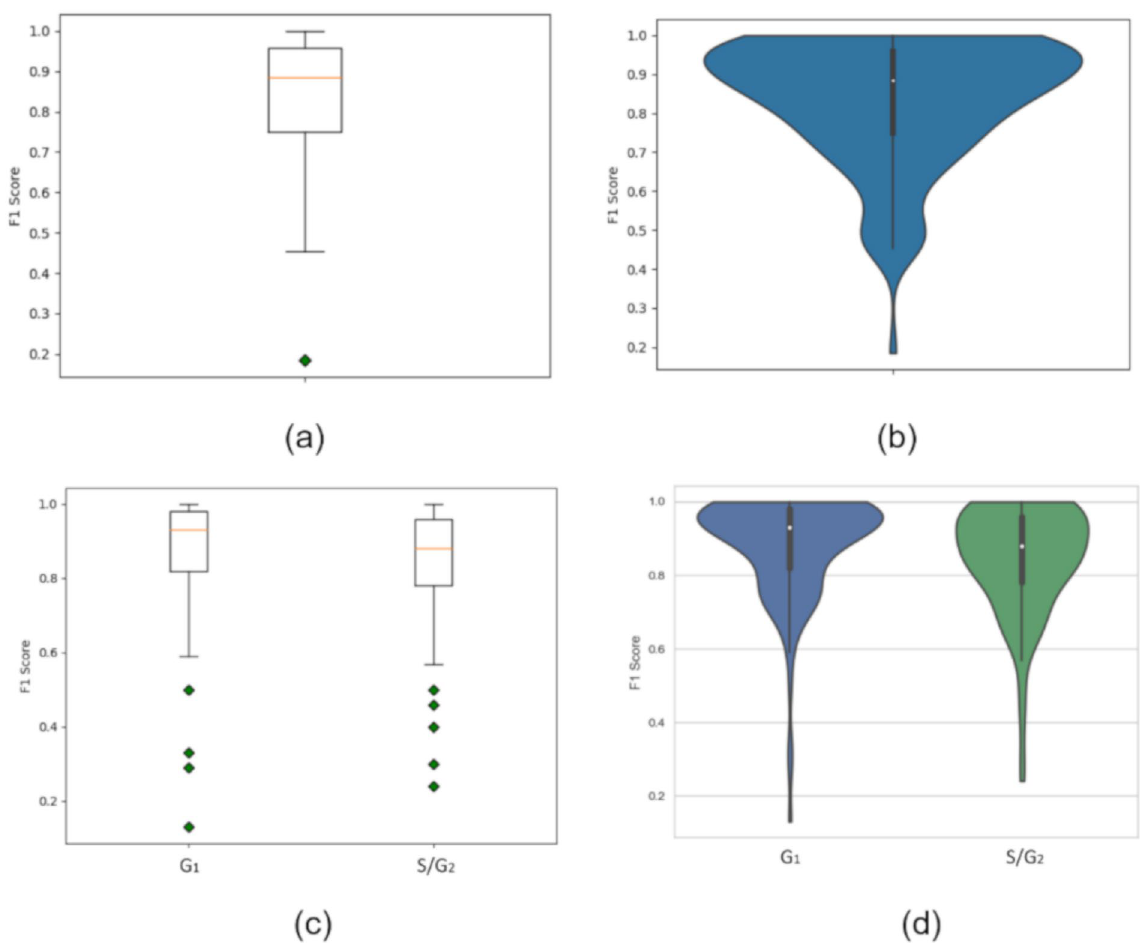
Figure 5. Distribution of nuclei classification (a) box plot of F1-Score (130 images). (b) Violin plot of F1-Score (130 images). (c) Box plot of F1-Score for class G 1 and class S/G 2 . (d) Violin plot of F1-Score for class G 1 and for class S/G 2